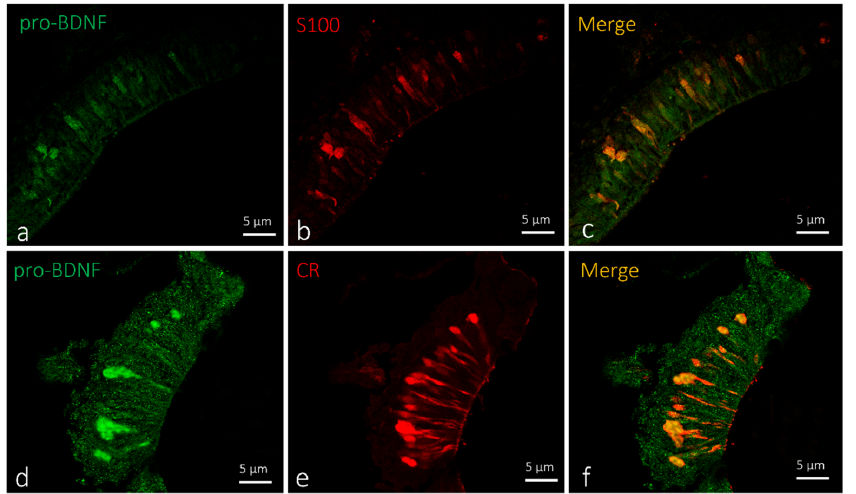
Figure 2. Olfactory lamellae of zebrafish larvae 5dpf, cross view. ( a – c ) Immunohistochemical detection (immunofluorescence method) of pro-BDNF and S100 protein. ( d – f ) Immunohistochemical detection (immunofluorescence method) of pro-BDNF and calretinin (CR). Subpopulation of olfactory epithelium sensory cells with an elongated shape showing immunoreactivity to ( a , d ) pro-BDNF, ( b ) S100 protein, and ( e ) calretinin. ( c , f ). Colocalization view. Magnification, 63 × . Scale bar, 5 µ m.